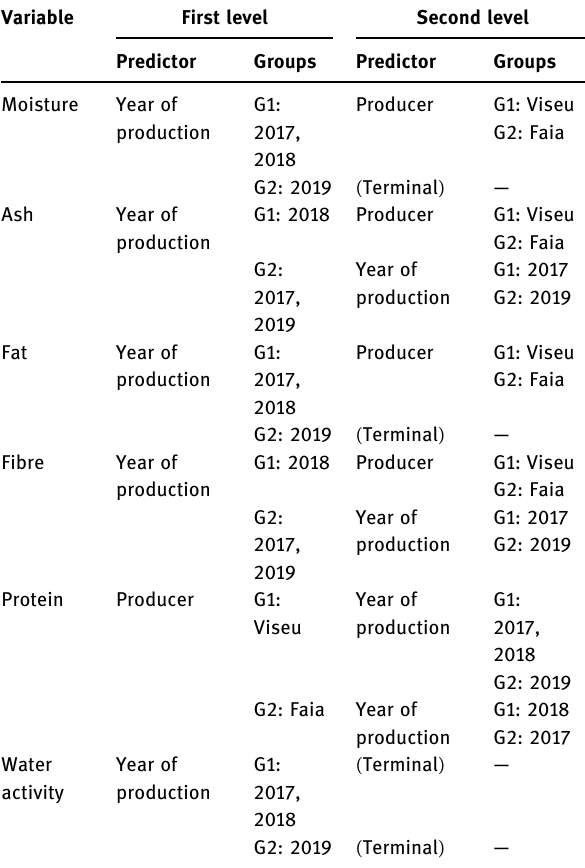
Table 11: Classi fi cation tree for chemical properties